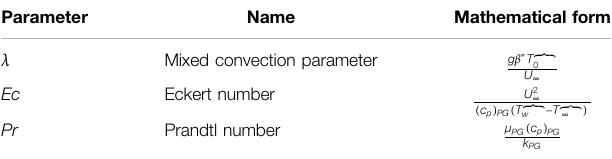
TABLE 3 | The governing fl ow quantities. Parameter Name Mathematical